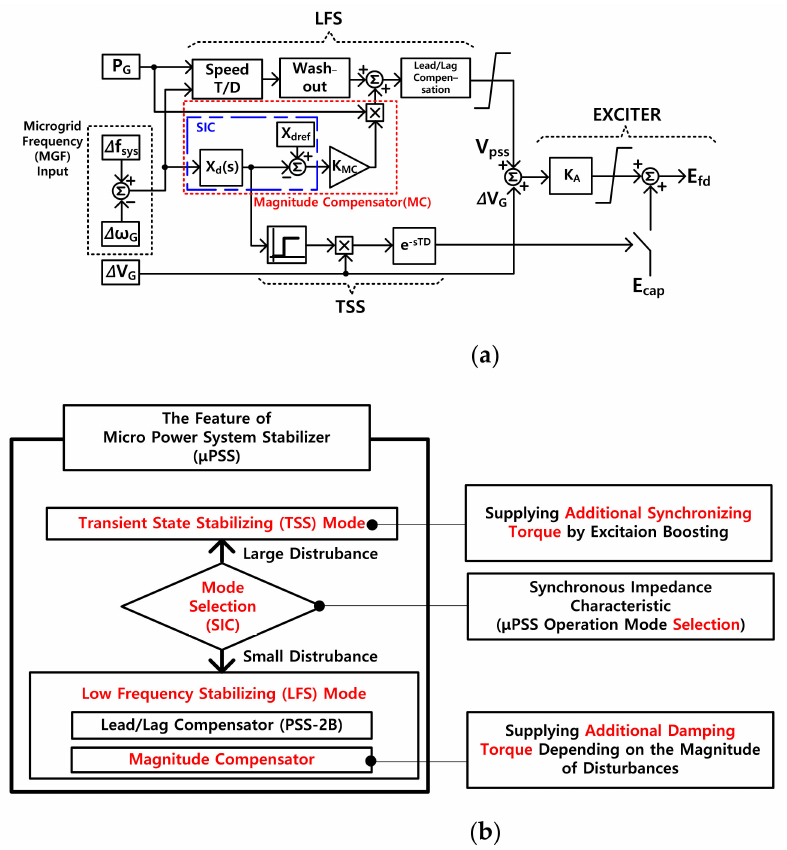
Figure 4. The micro-power system stabilizer ( µ PSS): ( a ) overall structure of the µ PSS and ( b ) the functional features of the µ